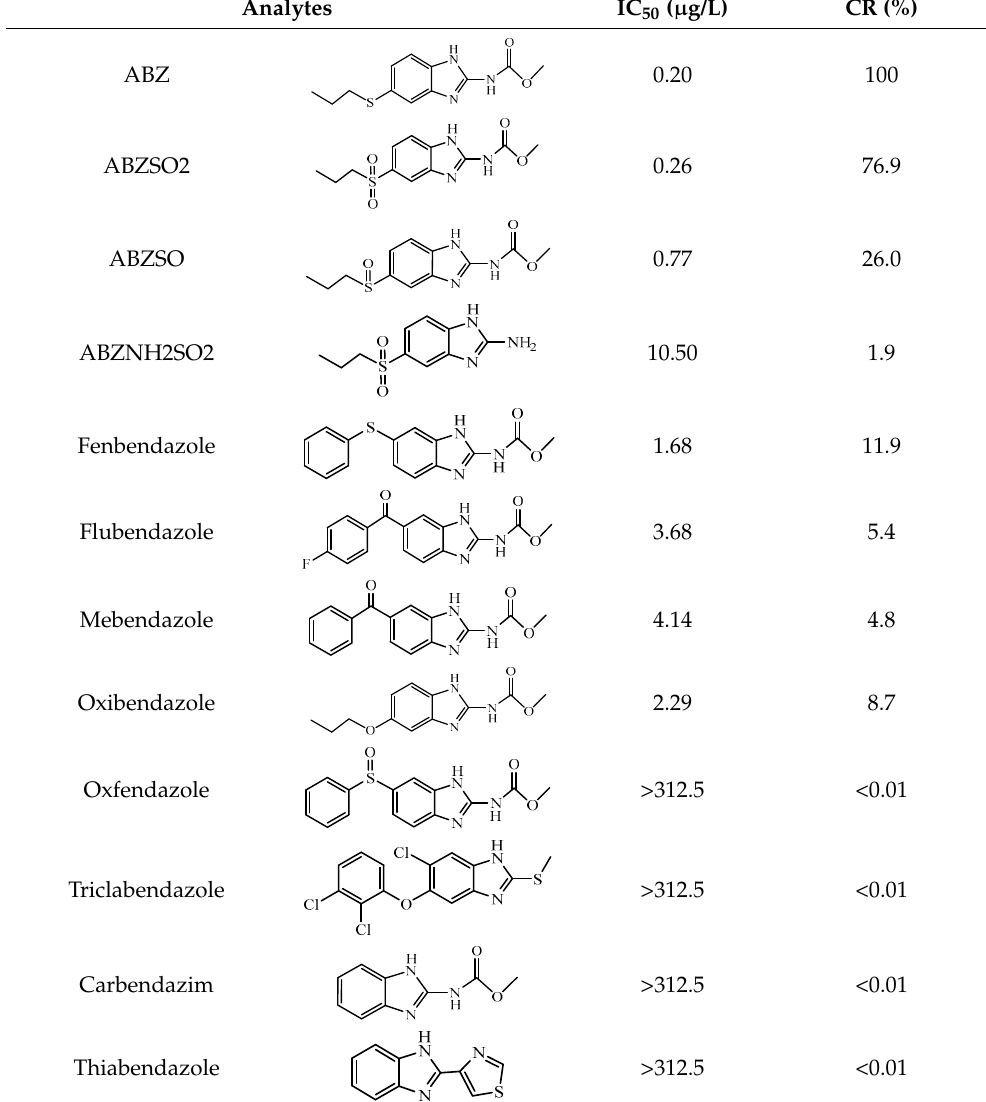
Table 2. Experimental IC 50 values and cross-reactivities of ABZs in optimized ic-ELISA.